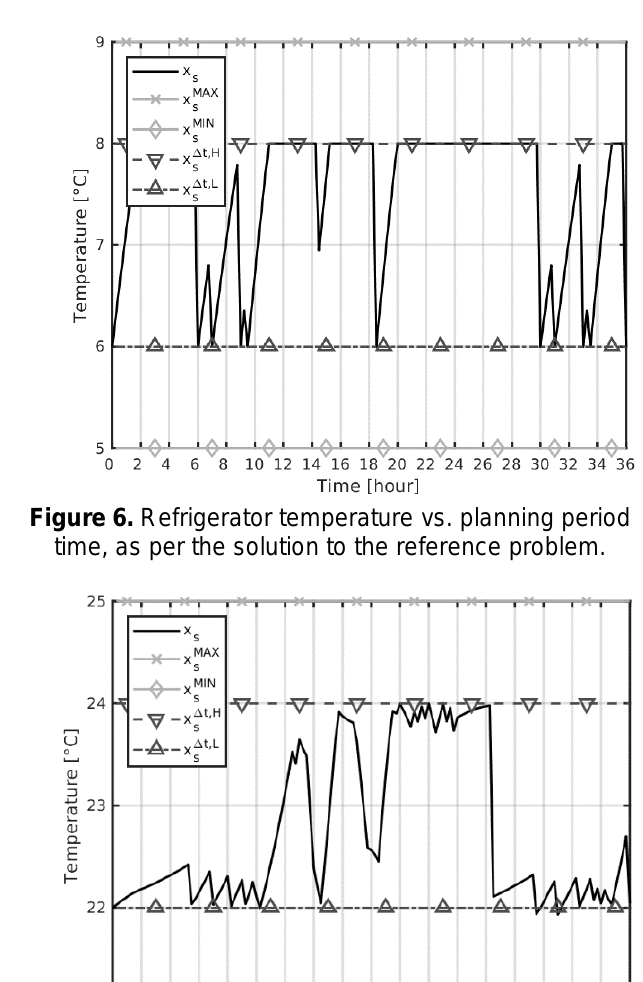
Figure 5 . Electrical energy price and power demand vs planning period time, according to the optimised solution to the reference problem (STD formulation; reference profiles; 15-minute time steps; 5 levels).